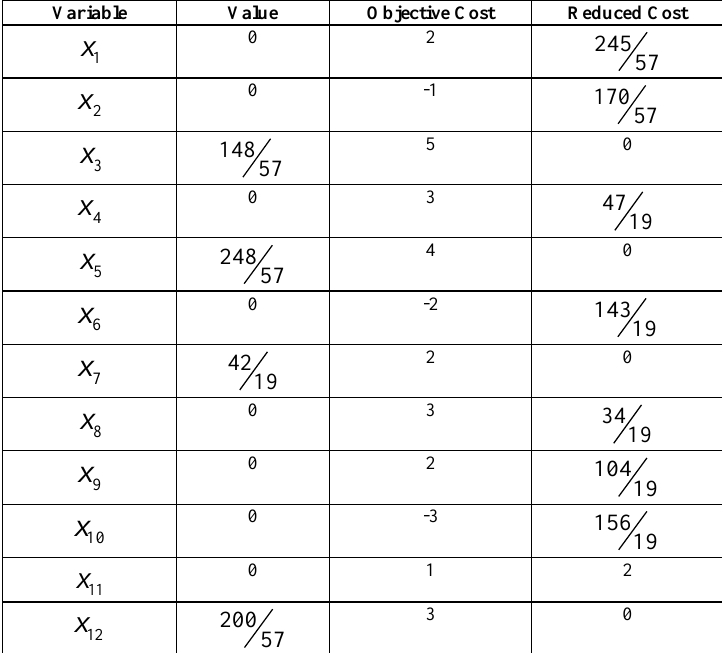
Table 3. Solution of LP of example